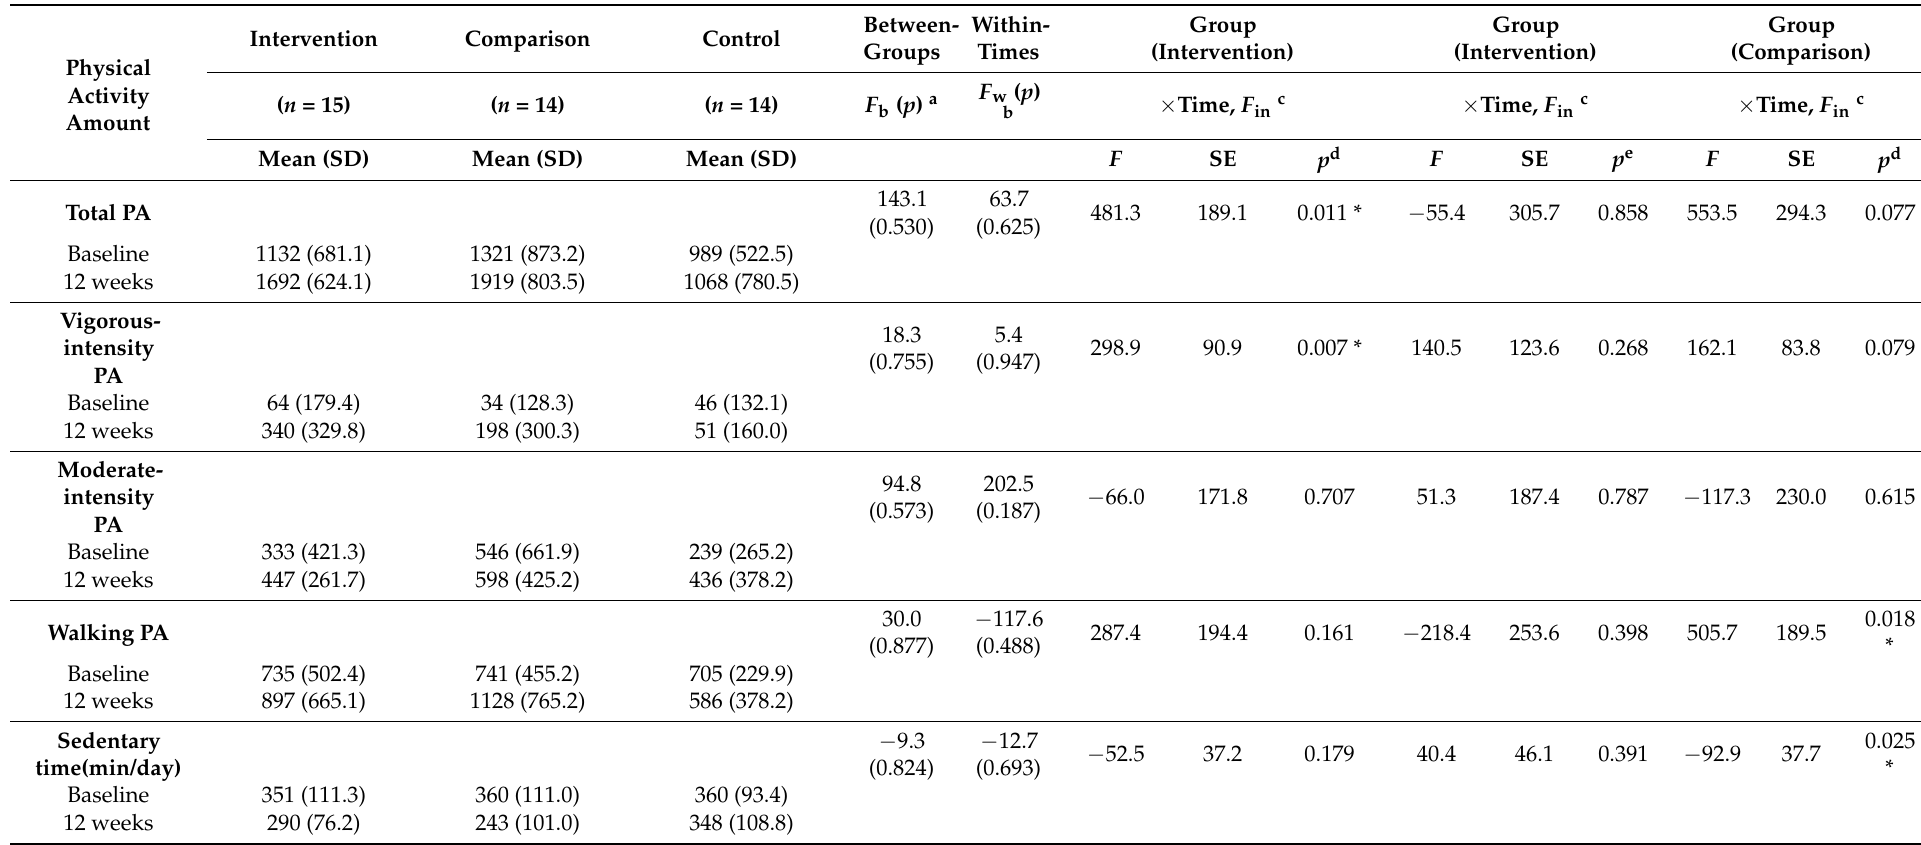
Between- Within- Group Groups Times (Intervention)